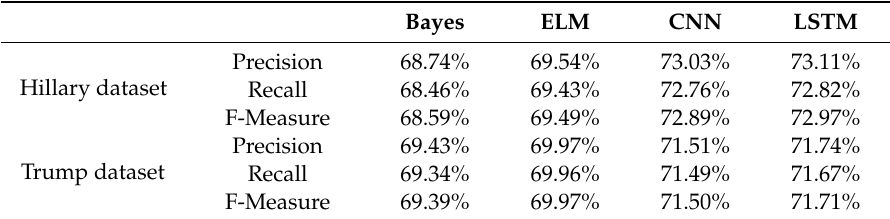
Table 2. Performance Comparison for Sentiment Classification.